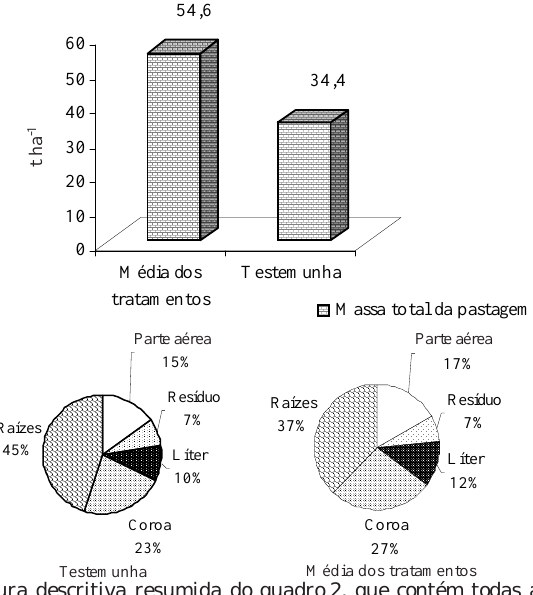
Figura 1. Produção de matéria seca de forragem e composição percentual das estruturas da planta de Brachiaria brizantha cv.